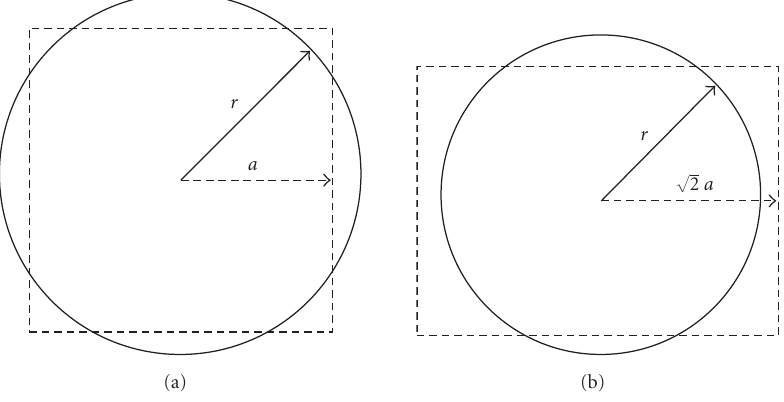
Figure 9: Geometry mismatch. A sphere is used to approximate a real cubic tumor. Size and location of the sphere are determined from projections of the cubic tumor in direction 1 (a) and direction 2 (b). r/a =